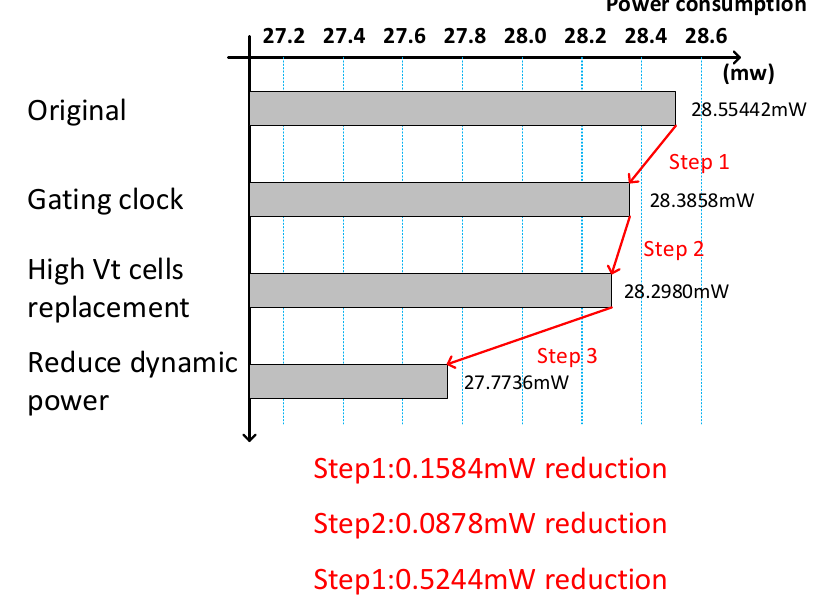
Figure 12. Analysis of power